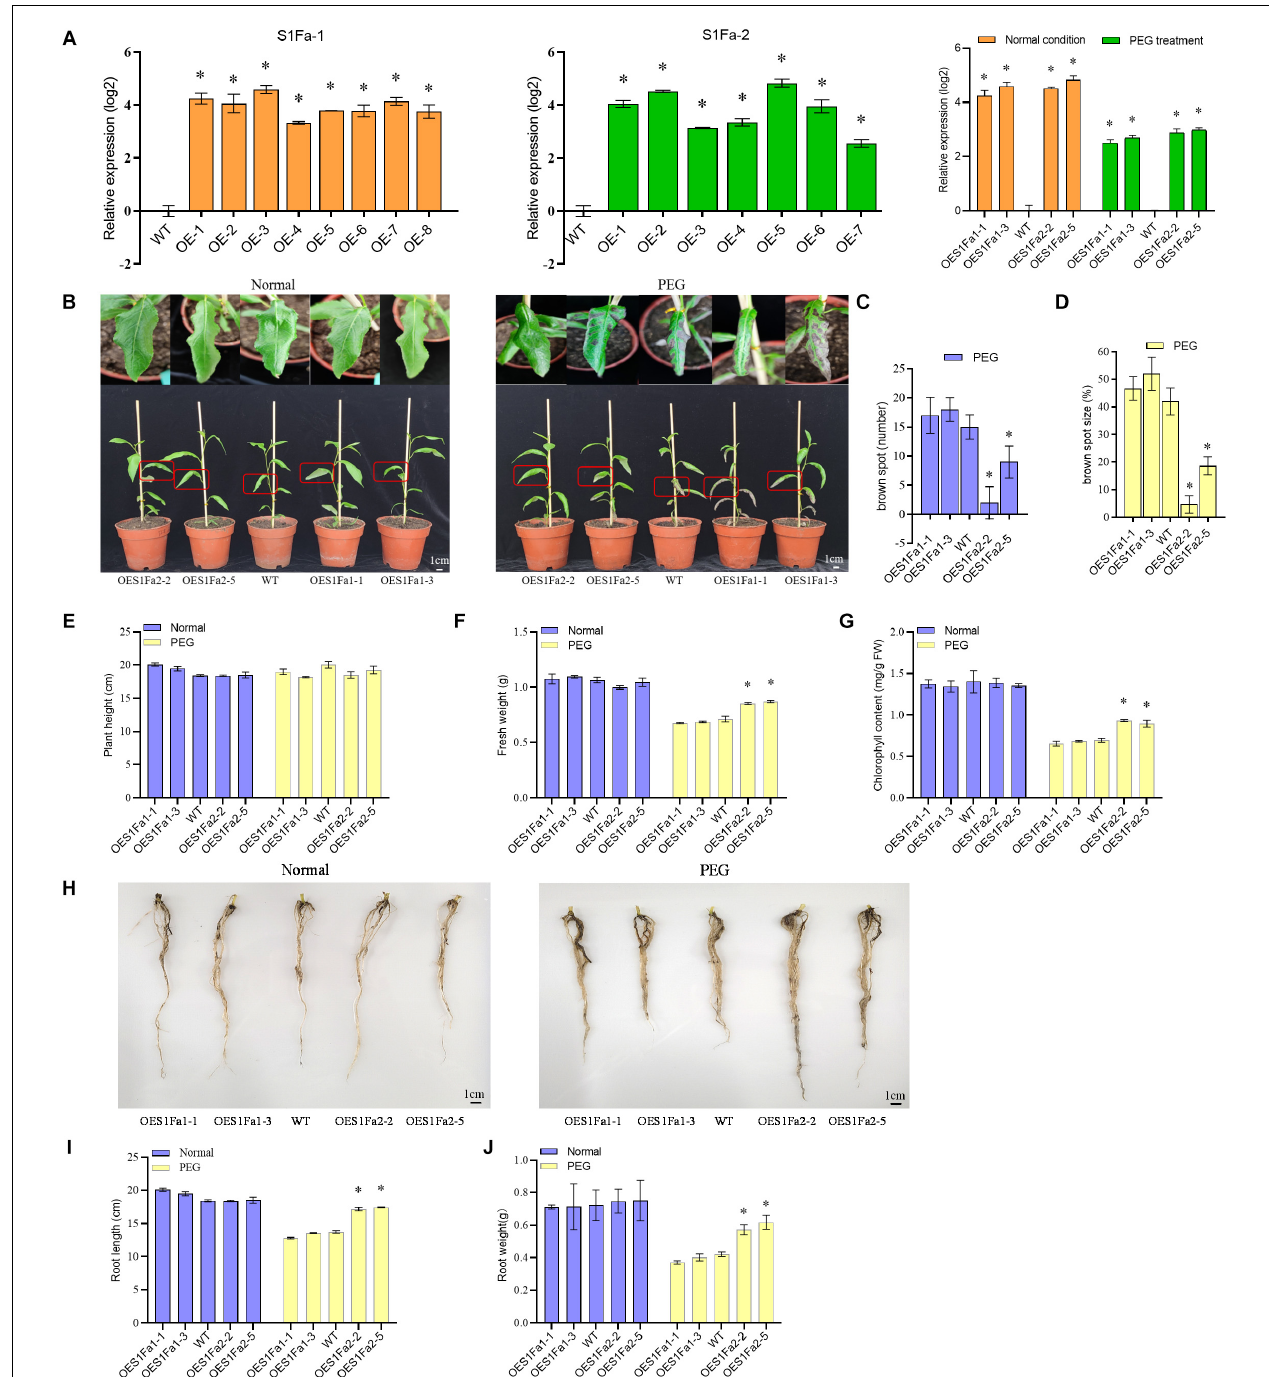
FIGURE 6 | PtS1Fa2 confers drought tolerance. (A) Determination of the overexpression of PtS1Fa1 and PtS1Fa2 in transgenic lines (OE). The relative expression of PtS1Fa1 and PtS1Fa2 in OE lines were divided by that in WT plants, and the ratios were log2 transformed. (B) Comparison of the growth of OE lines and WT plants. (C) The number of brown spots. (D) The percentage of Brown spots size (E–G) Measurement of the plant height (E) , fresh weight (F) , and chlorophyll content (G) . (H–J) Comparison of the root phenotype (H) , root length (I) , and root weight (J) of OE and WT lines under normal conditions or the conditions of drought stress. Control: The well-watered plants were grown under normal conditions. All the plants were grown in the greenhouse at 23 ◦ C under a 16/8 h light/dark cycle and well-watered. PEG: 20% PEG6000 treatment for 15-day. The data represent means of three independent experiments. Each sample contains at least 3 plantlets. The error bar represents the standard deviation (STD) of the three biological repetition. Asterisks indicate significant differences between transgenic strains and WT ( P > 0.05).